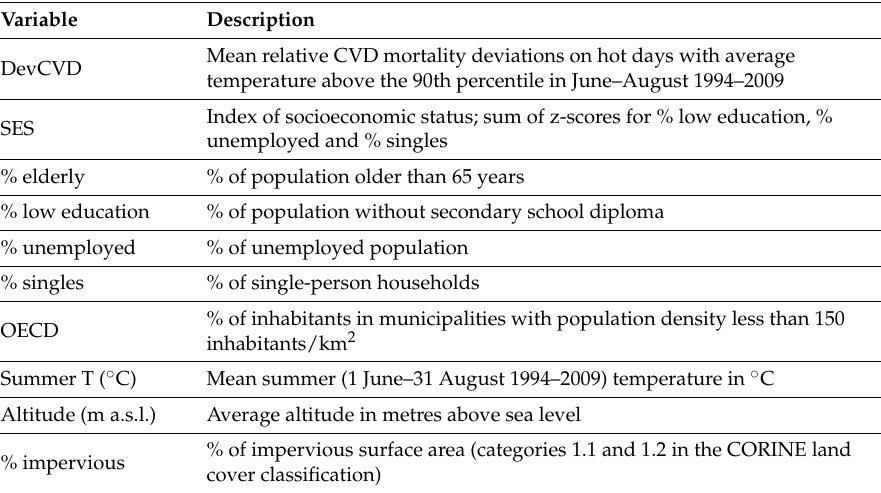
Table 1. District characteristics tested in the